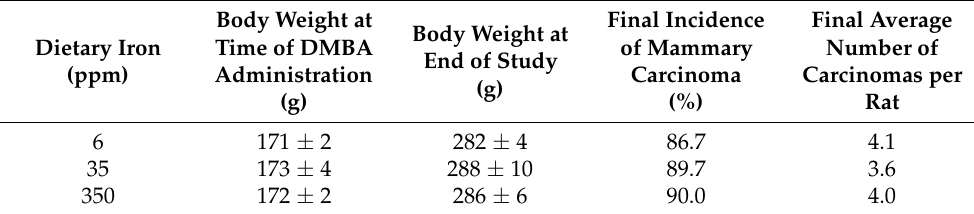
Table 3. Effect of dietary iron on the distribution of tumor types in the mammary gland.